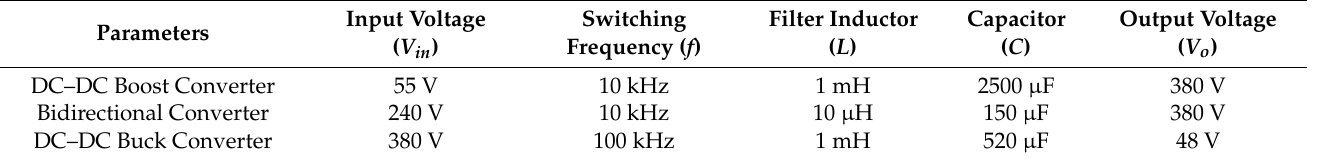
Table 1. Simulation parameters of dc nanogrid-based DES.